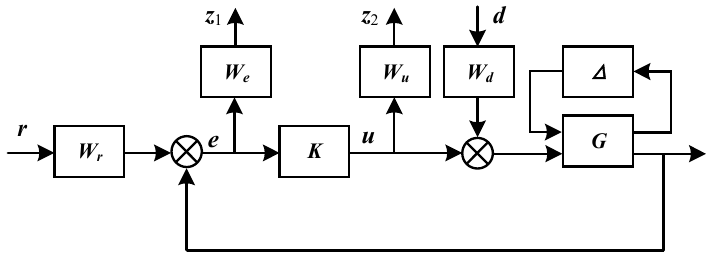
Figure 7. Block diagram of μ -synthesis control.